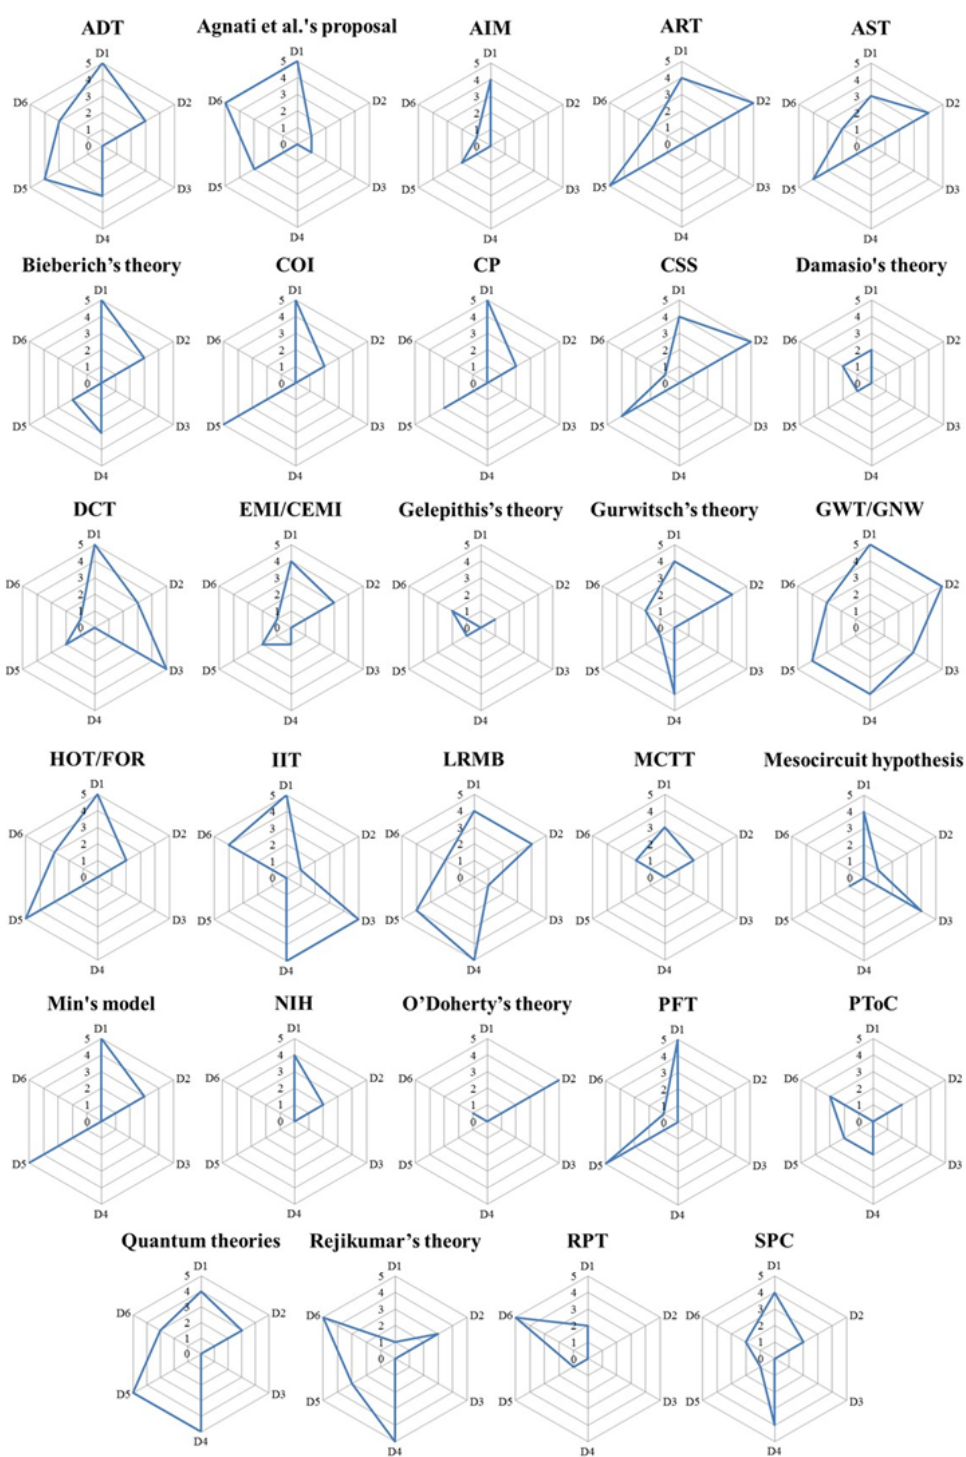
Figure 3. Graphic representation of the maximum scores obtained in the six dimensions analyzed by each theory. The figures depicted the scores achieved by each theory (displayed in alphabetical order) in each dimension of the dimensional model. We considered the maximum score for each theory among the articles belonging to it. The y-axis represents the scores ranging from 0 to 5. D1 refers to the neural correlates of consciousness dimension. D2 refers to the association between consciousness and other cognitive functions dimension. D3 refers to translation from theory to clinical practice dimension. D4 refers to the quantitative measures of consciousness dimension. D5 refers to consciousness, sensory processes, and the autonomic nervous system dimension. D6 refers to the subjectivity dimension.